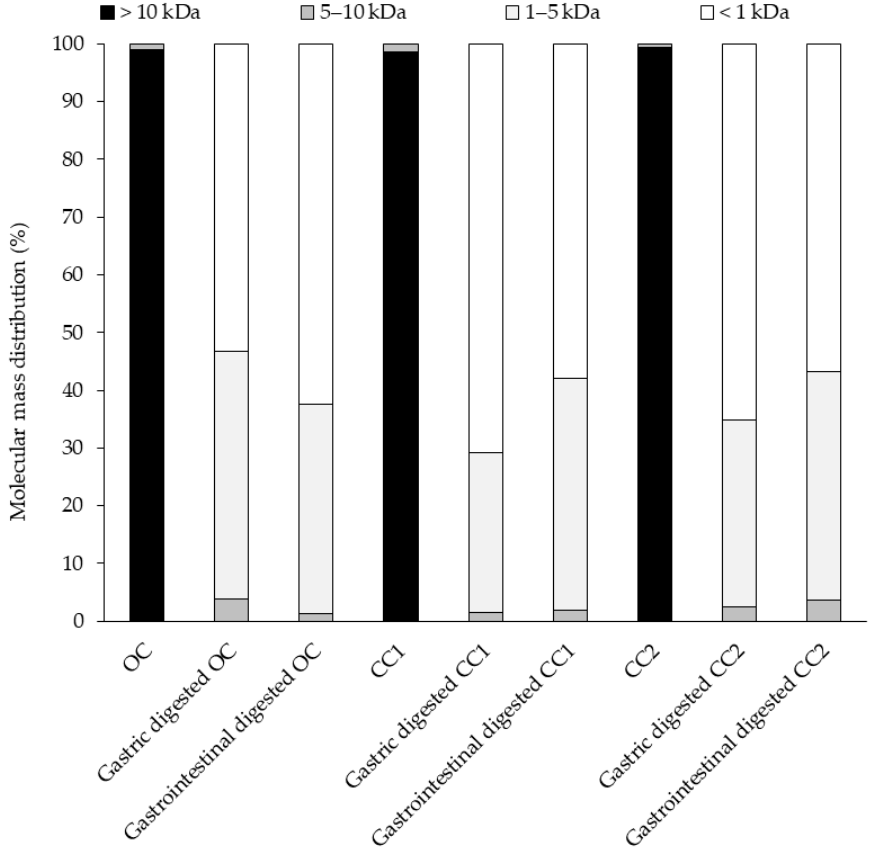
Figure 5. Molecular mass distribution profiles of protein extracts from one organically (OC) and two conventionally (CC1 and CC2) cultivated hempseeds and their associated gastric and gastrointestinal digested samples.